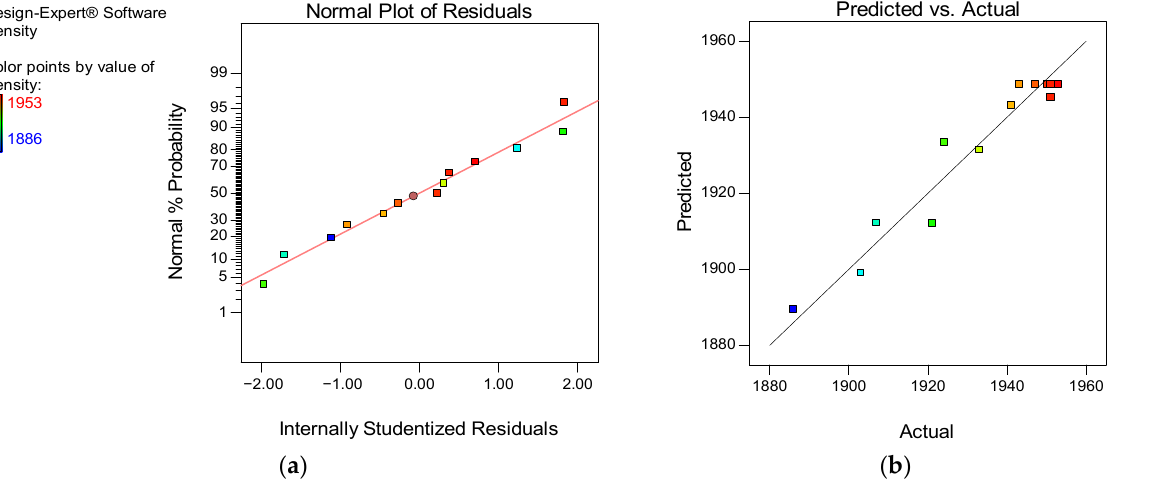
Figure 15. ( a ) The normal plot of residuals and ( b ) actual versus predicted plot for the OBA ‐ RECC D model.